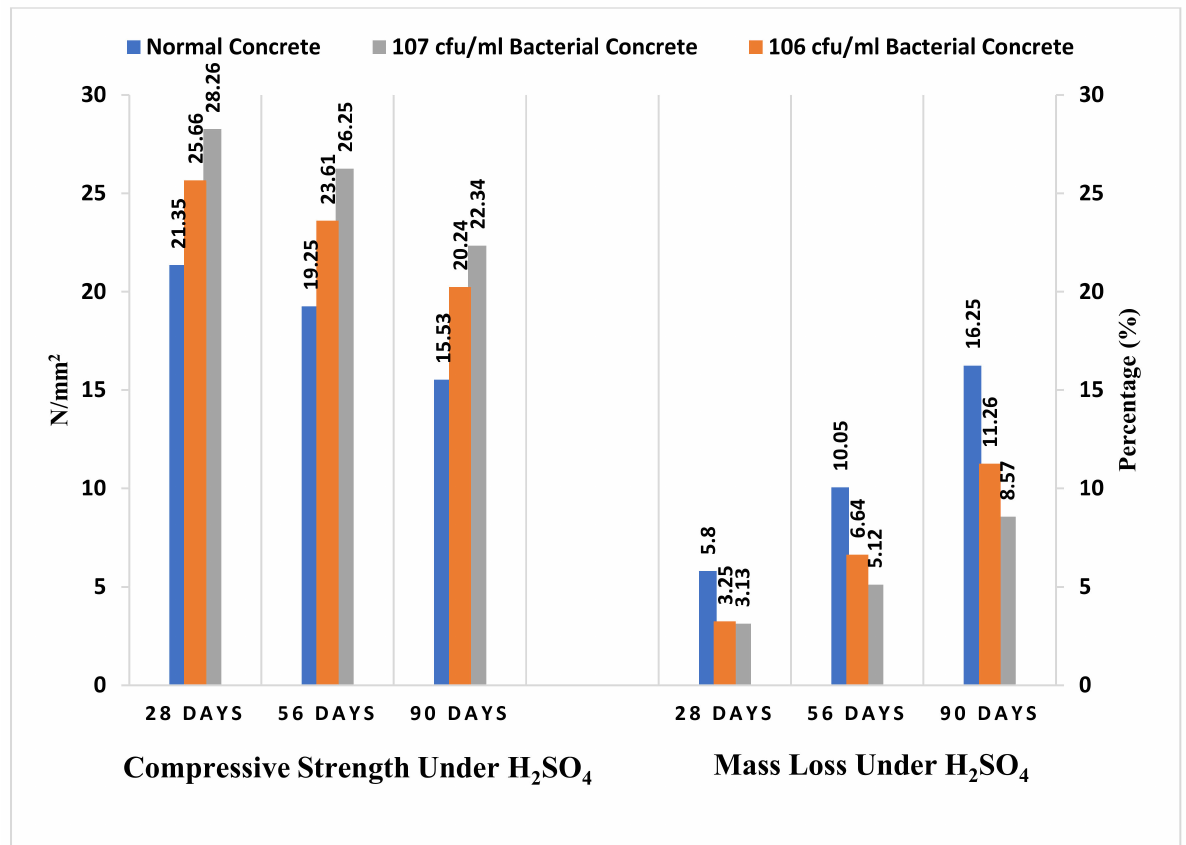
Figure 7. Effect of acid attack on bacterial concrete with different interval days.